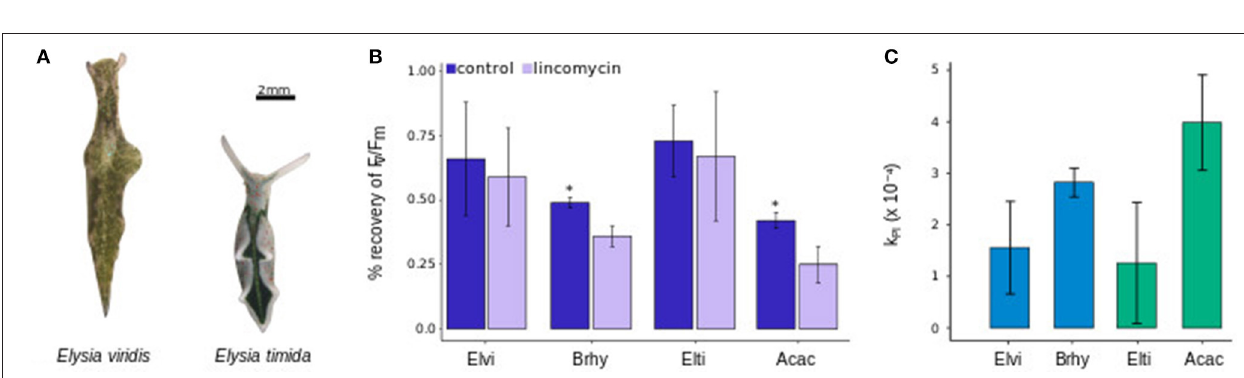
FIGURE 6 | Images of E. viridis and E. timida (A) and the %-recovery of the F v /F m of chloroplasts in B. hypnoides (Brhy) , A. acetabulum (Acac) and of kleptoplasts in E. viridis (Elvi) and E. timida (Elti) after exposure for 1h at 1,300 µ mol photons m − 2 s − 1 of red light (B) and the respective calculation of the constant rate of photoinhibition, k PI (C) . Scale bar represents 2mm. Stars indicate significant differences between control and lincomycin treated samples. All measurements were performed in biological triplicates and error bars show the standard